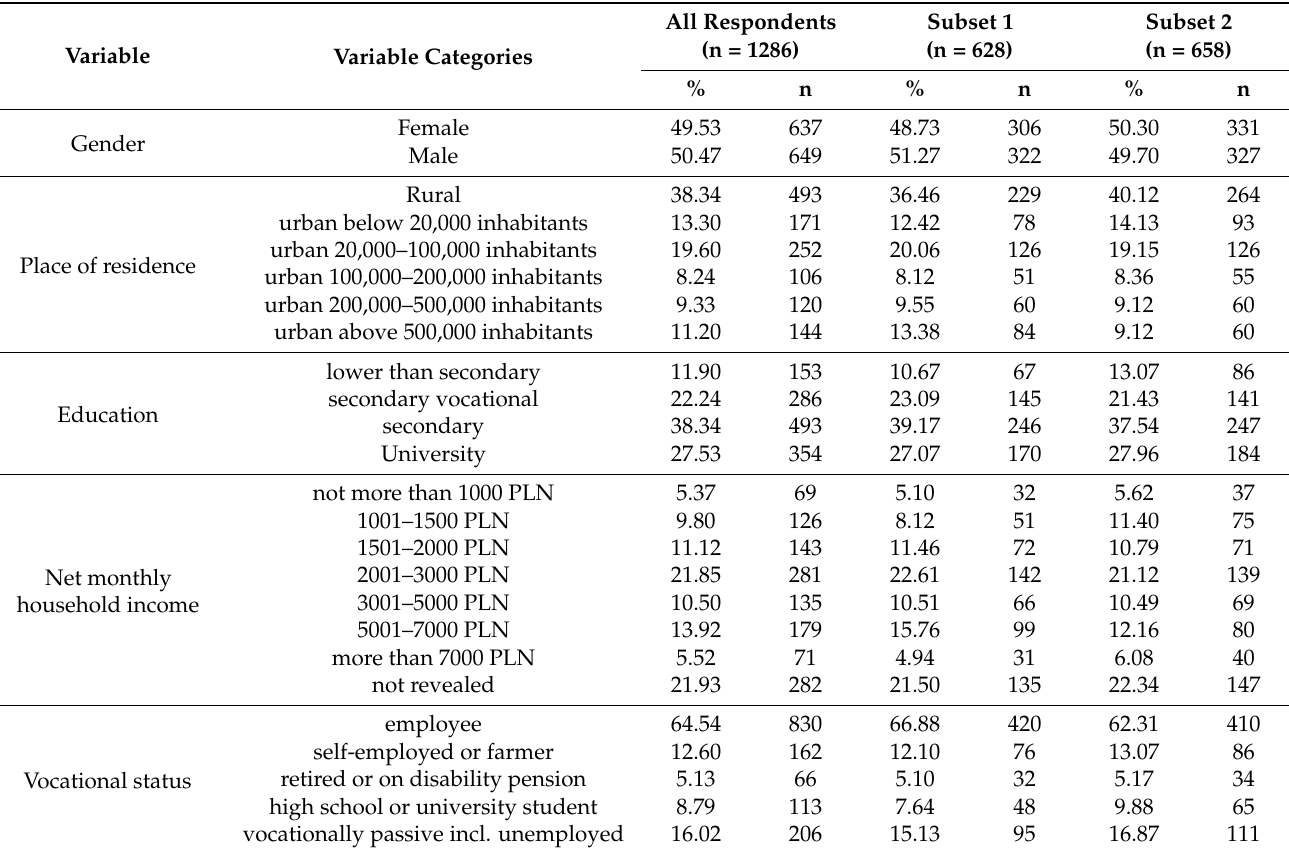
Table 1. Characteristics of the study sample and subsets used for the exploratory and confirmatory factor